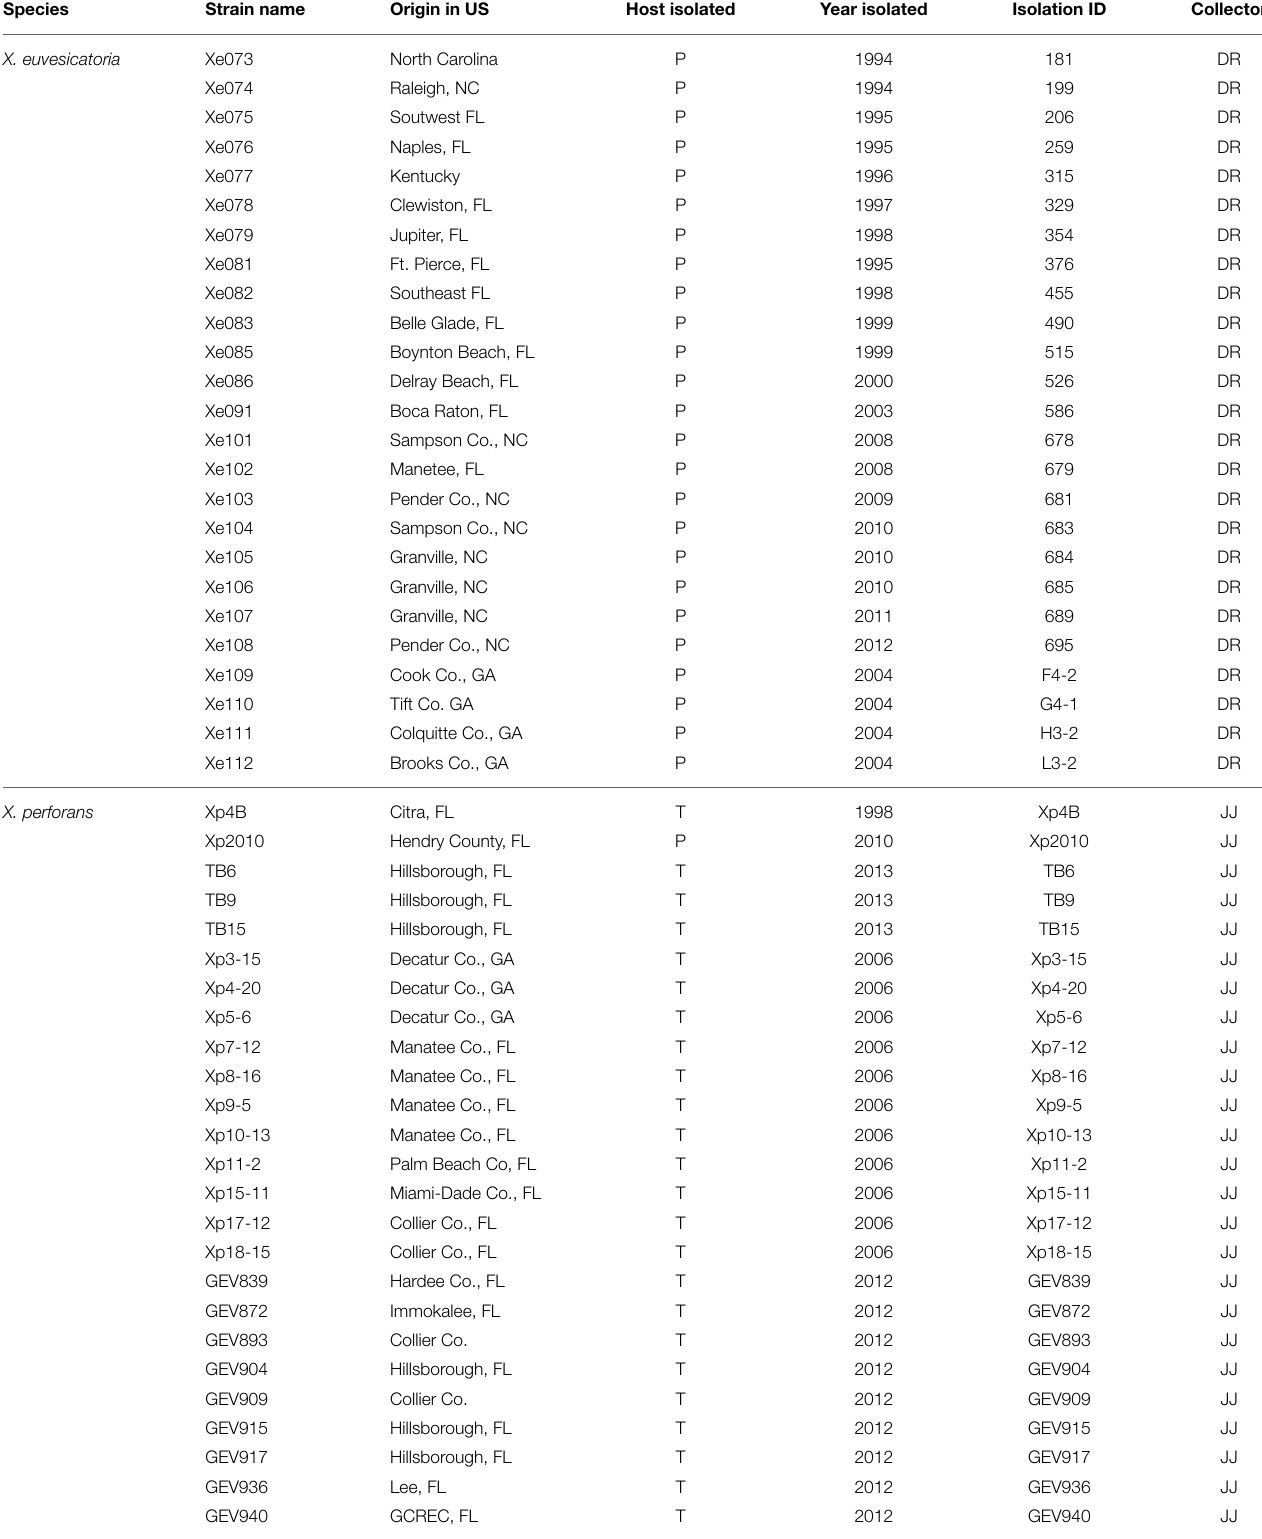
TABLE 1 | Summary of Xanthomonas field strains sequenced in this paper.